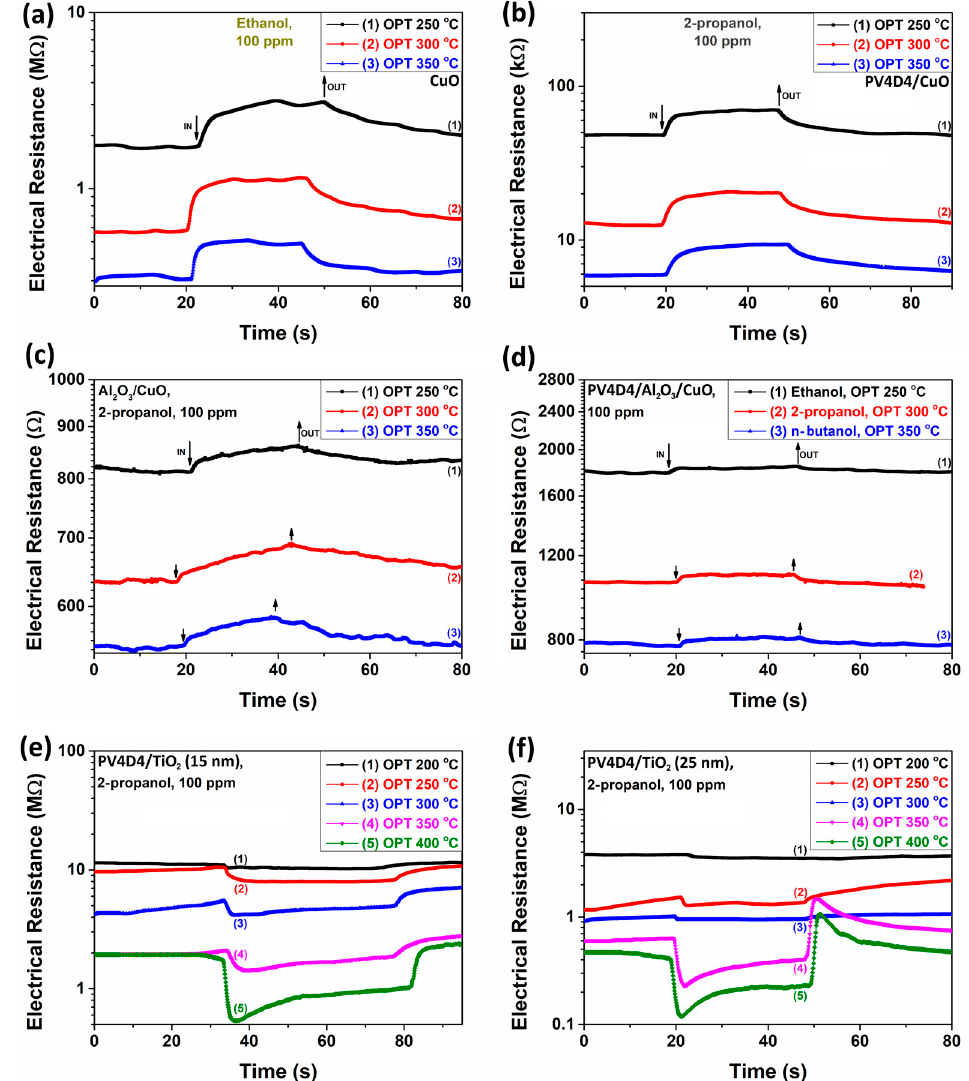
Figure A2. Electrical resistance at different operating temperature for the: ( a ) uncoated CuO structures to ethanol vapor; and ( b ) CuO structures with PV4D4 thin film to 2-propanol vapor. Electrical resistance at different operating temperature for the: ( c ) uncoated Al 2 O 3 /CuO structures to 2- propanol vapor; and ( d ) Al 2 O 3 /CuO structures with PV4D4 thin film to different vapor. Electrical resistance at different operating temperature for the TiO 2 structures with PV4D4 thin film to 2- propanol vapor. The investigated TiO 2 structures are: ( e ) 15 nm and ( f ) 25 nm